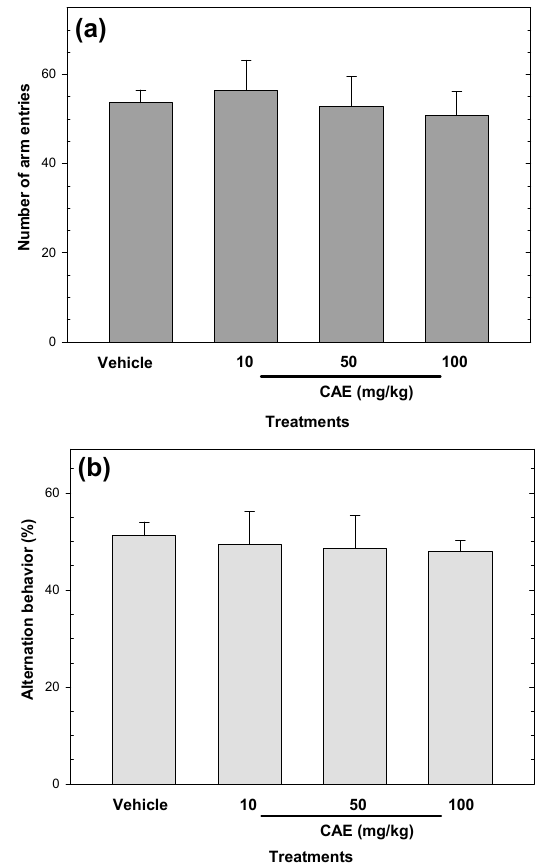
Figure 8. The effects of CAE on spatial working memory were evaluated by spontaneous alternation behavior ( a ) and the number of arm entries ( b ) measured during an 8 min session in the Y-maze test. Bars represent mean values (± SEM) for the experimental group. n = 8, ** p < 0.05 compared to the vehicle group.